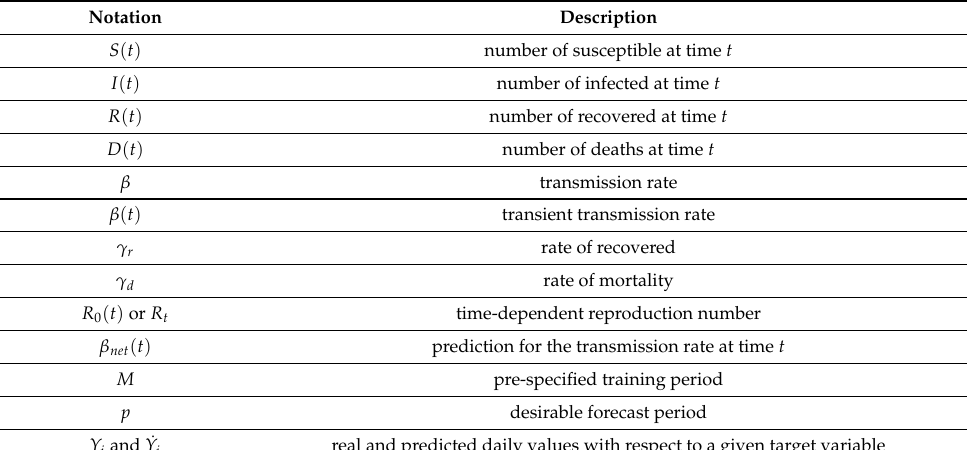
Table 1. List of